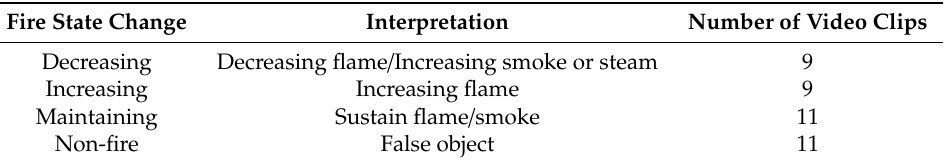
Table 7. Fire detection accuracy of Faster R-CNN.